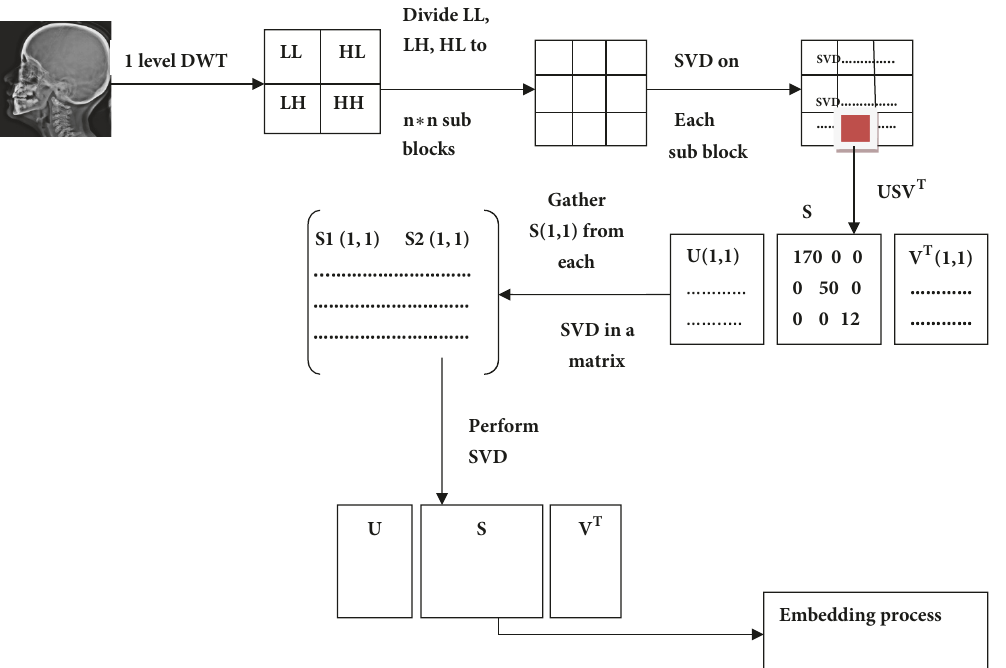
Figure 2: Selected “S” coefficients of the second level of